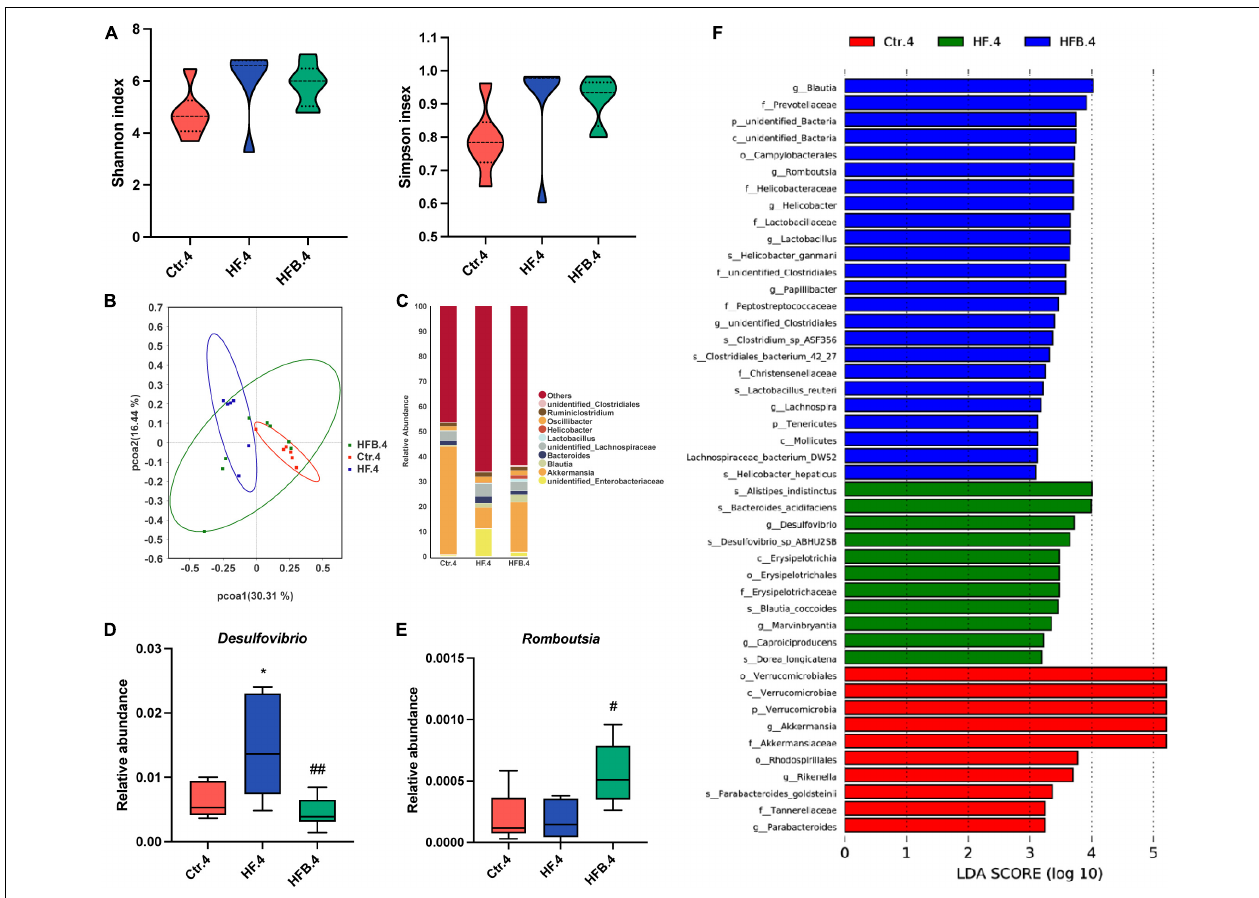
FIGURE 4 | Maternal betaine alters the gut microbiota in early-life high-fat diet offspring at 4 weeks of age. The cecal contents were collected from offspring at 4 weeks of age. (A) Shannon index (left) and Simpson index (right); (B) PCoA plots of gut microbiome; (C) relative abundance of the top 10 species at the genus level; (D) relative abundance of Desulfovibrio ; (E) relative abundance of Romboutsia ; (F) distinct taxa identified in the three groups using LEfSe analysis. The colors represent the group in which the indicated taxa is more abundant compared to the other group. Ctr.4, 4-week-old offspring of dams fed with the standard control diet; HF.4, 4-week-old offspring of dams fed with the high-fat diet; HFB.4, 4-week-old offspring of dams fed with the high-fat diet with betaine. Data are expressed as means ± S.E.M. ( n = 6–8/group). One-way ANOVA; * p < 0.05 vs. Ctr, # p < 0.05 vs.